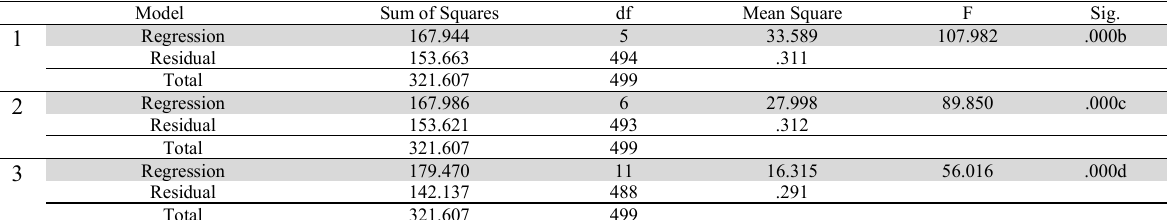
Evaluation results of the suitability of the model